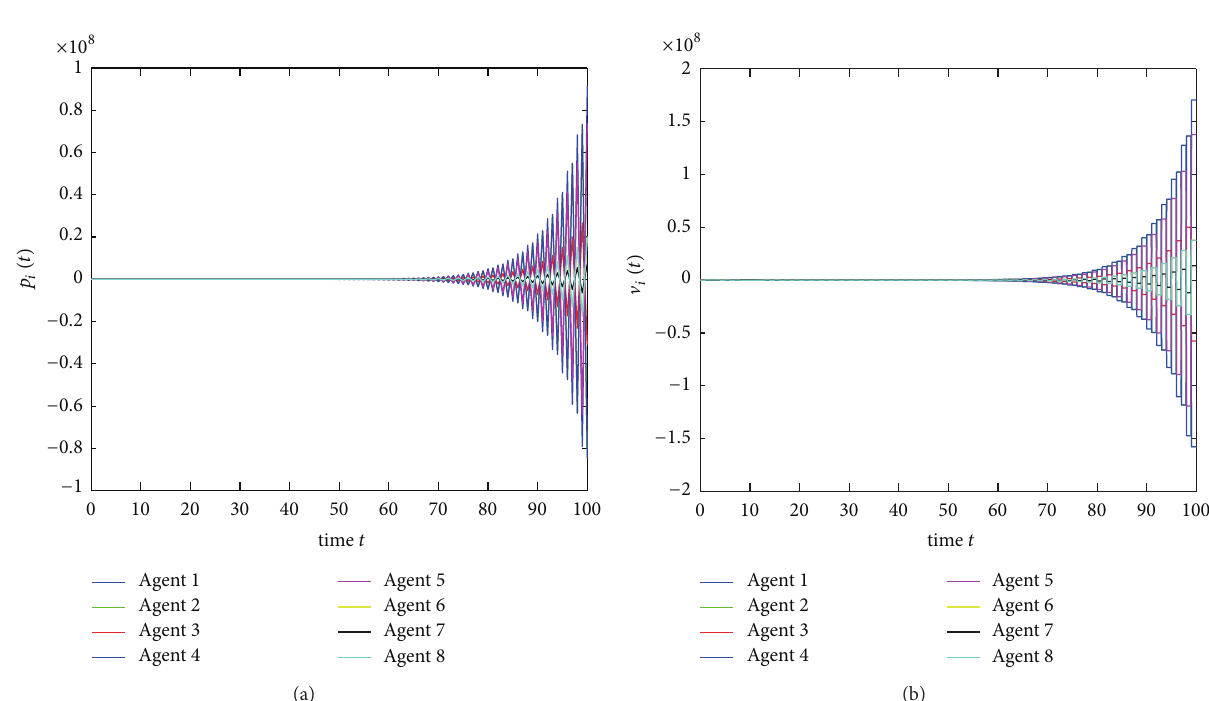
Figure 3: Trajectory of controlled multiagent system (3) with communication graph shown in Figure 1, where 𝛽 1 = 0.55 , 𝛽 2 = 0.05 , 𝛼 = 1 . Evolution of (a) 𝑝 𝑖 and (b) V 𝑖 .